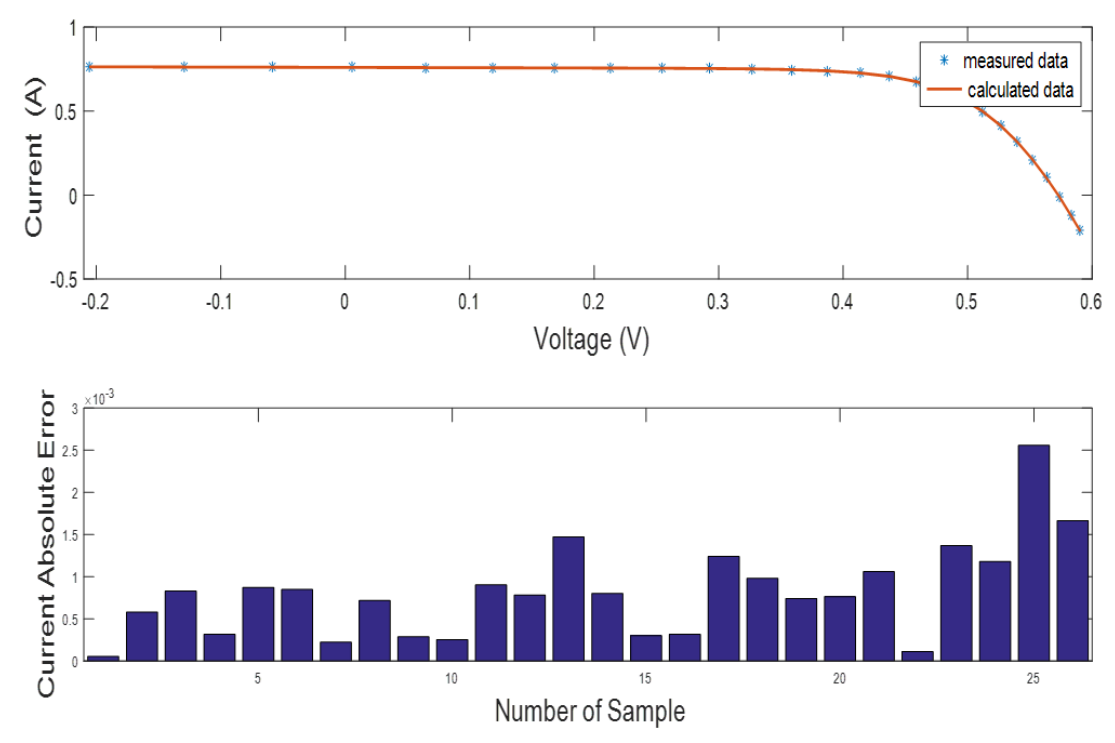
Figure 11. The TDMSC’s I–V curve based on the best solution from the INFO algorithm.